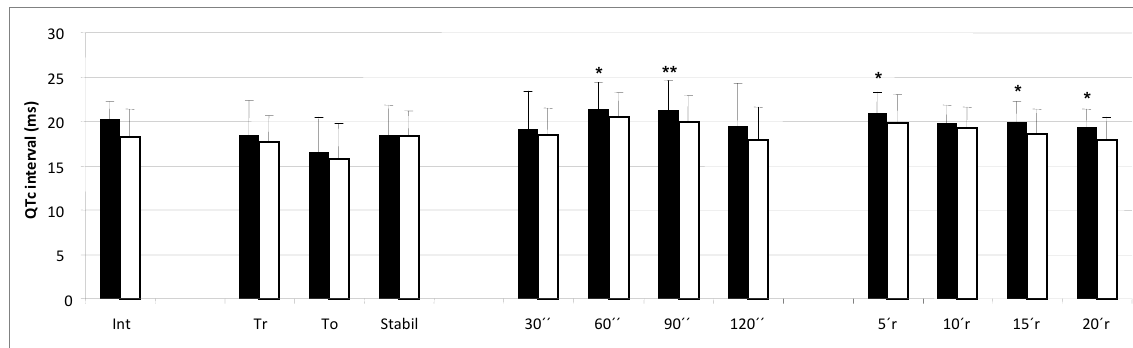
Figure 5. Mean ± SD values of the QTc-interval duration in intact animals (Int), after tracheotomy (Tr), thoracotomy (To), 5 minutes after stabilization (Stabil), in each 30 seconds of a 2-minute apnoeic episode, and after 5, 10, 15, and 20 minutes of artificial reoxygenation. Empty and black columns refer to light and dark parts of the day, respectively. The level of significance of differences between the light and dark part of the rat daily regimen is indicated by the symbol (* p < 0.05, ** p < 0.01, *** p <